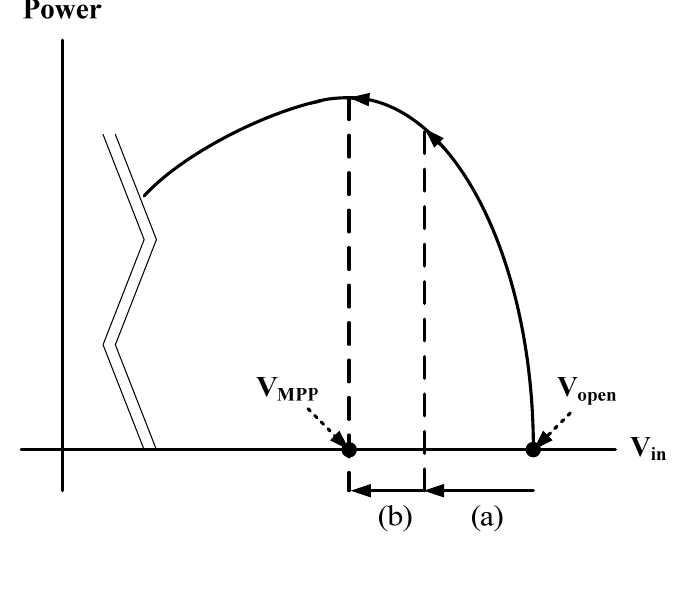
Figure 3. MPPT operation: the initial condition (a) and the later condition